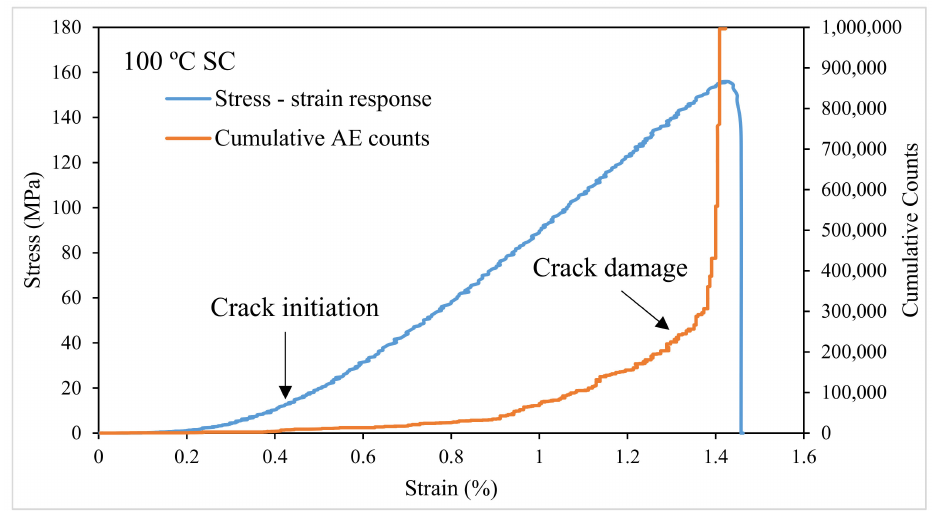
Figure 9. Stress-strain response accompanied by AE data for a specimen pre-heated up to 100 ◦ C and subjected to slow cooling